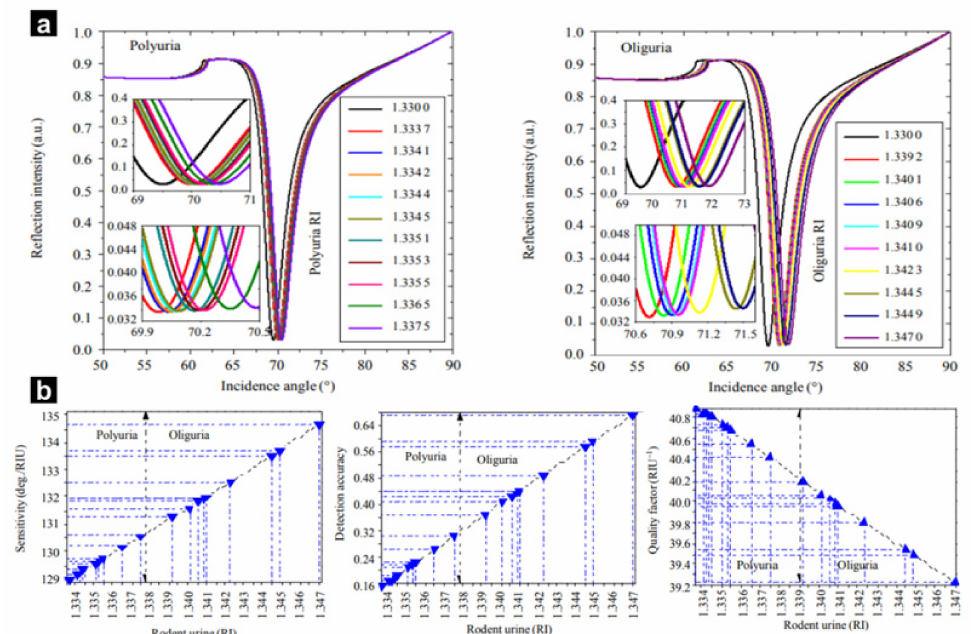
Figure 2. ( a ) SPR signal intensity vs. incident angle plot with polyuria (left) and oliguria (right). ( b ) Variation in parameters for different sensing medium refractive indices in pure water, polyuria, and oliguria. With permission from [76], Copyright 2020,